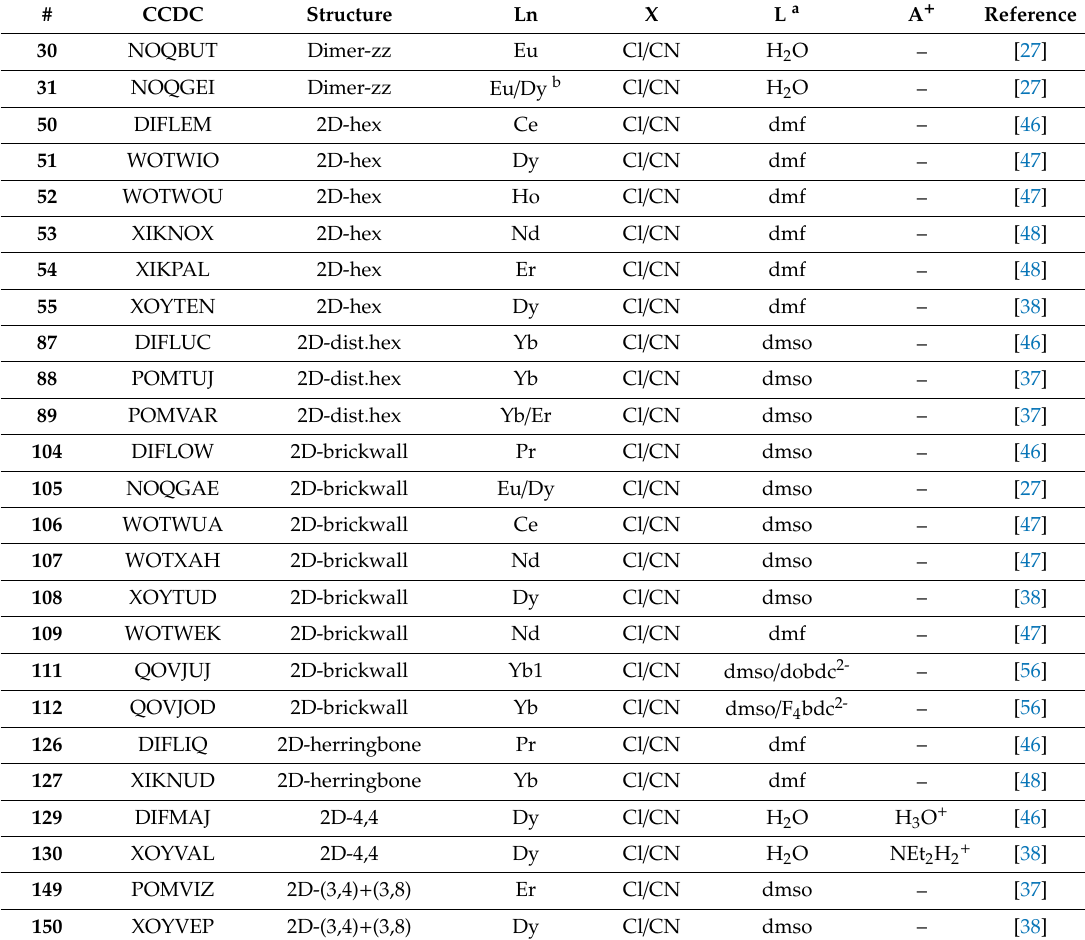
Table 11. Structurally characterized Ln compounds with